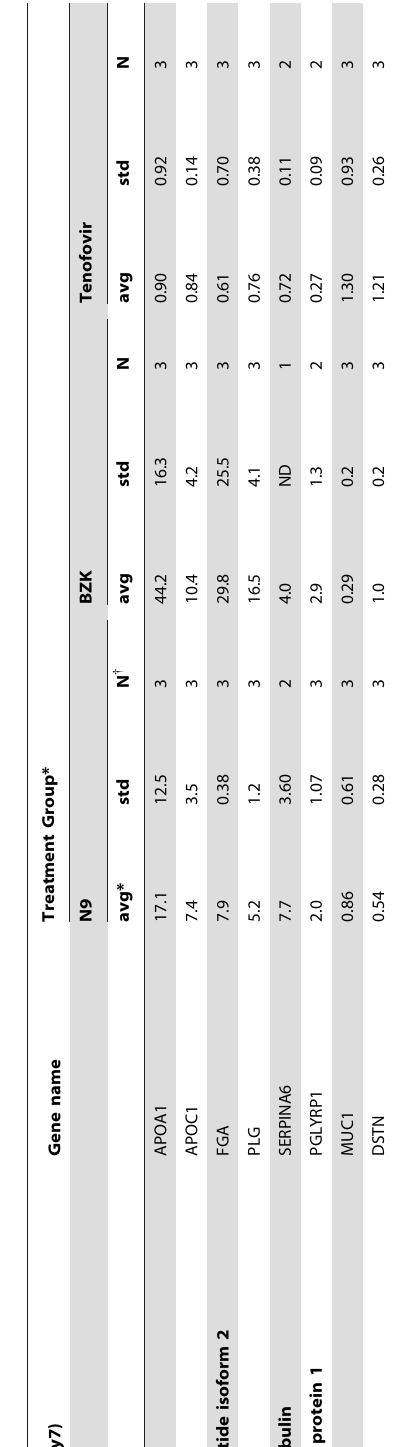
Figure 6. mRNA expression of cyclooxygenase-2 (cox2), Interleukin 8 (IL-8), mucin 5B, and olfactomedin-4 (OLFM-4) in V k 2 cells treated with N9 for 6, 24, or 48 hours. Shown is the average of two replicate experiments, each sample performed in duplicate for each time point. Also shown is the relative expression levels of N9 treated cells compared to untreated cells, which was set to an expression level of 1 (dashed line). Statistical analysis was performed using a two-tailed Student’s T-test of N9 samples compared to untreated controls at each time point (***=p # 0.001, **=p # 0.01, *=p # 0.05, NS=not significant).